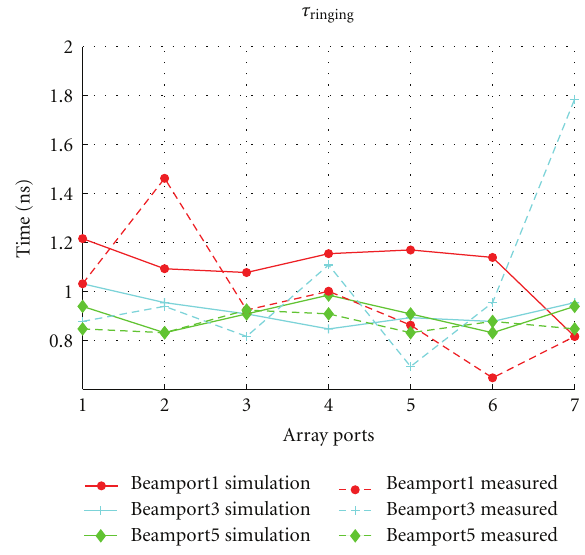
Figure 11: Output ringing time: Simulation and